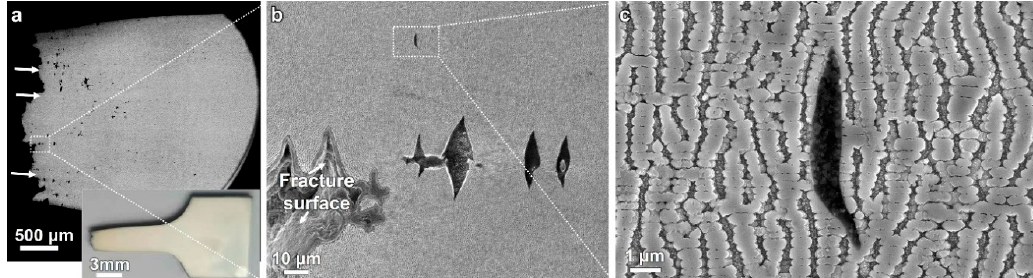
Figure 11. Fracture analysis after the tensile test at 1100 °C. ( a ) Side view of fractured sample (Backscattered electron image). The inset is an optical photograph of the necked sample. ( b ) Micro-cracks in the interdendritic region near fracture surface, captured from the area marked out by white dashed rectangle in ( a ). ( c ) Magnified microstructure near the fracture surface, obtained from the white rectangle in ( b ). The loading direction is horizontal in all images.